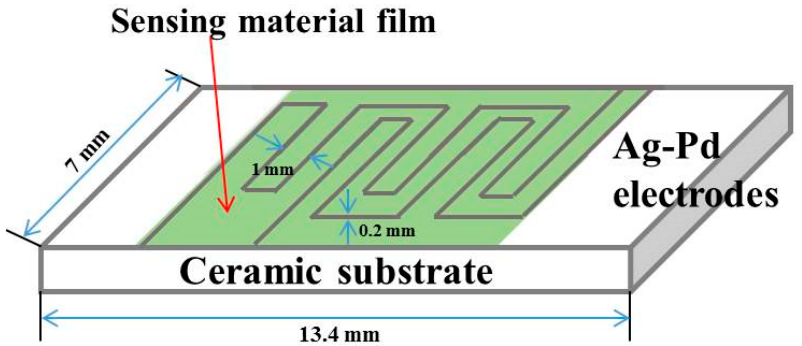
Figure 1. Schematic diagram of a gas sensor manufactured.